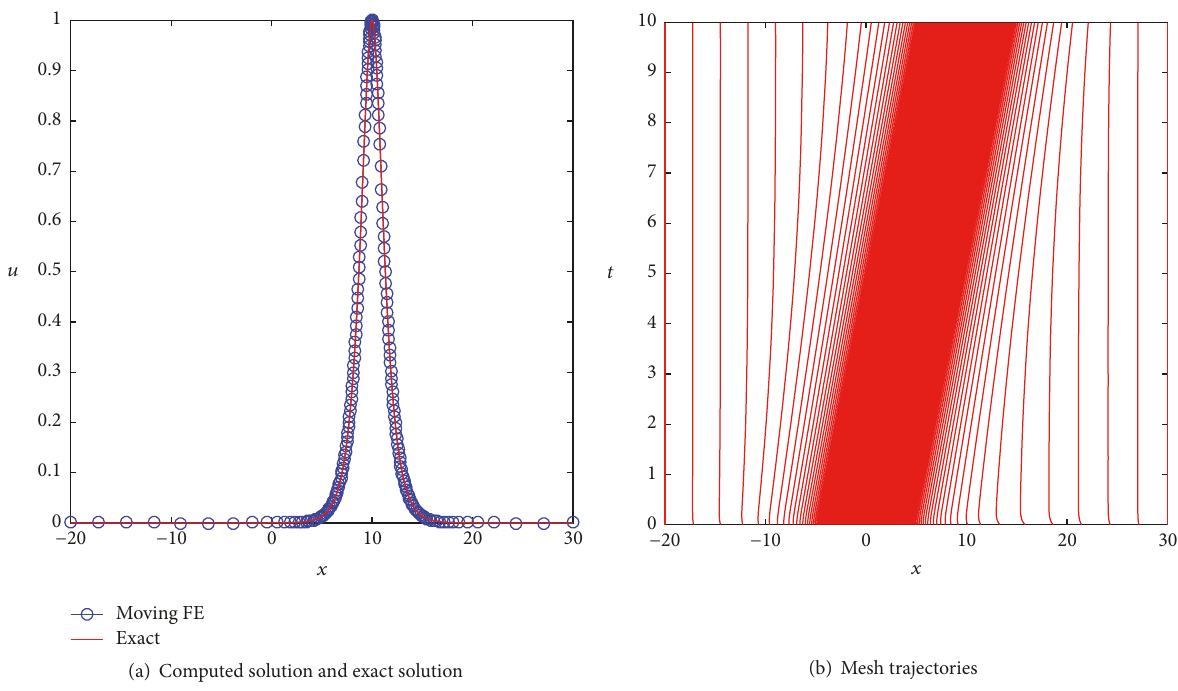
Figure 1: Example 1. (a) The exact solution and the numerical solution based on adaptive moving mesh with element number 𝑁 = 200 at 𝑡 = 10 ; (b) the corresponding mesh trajectories.